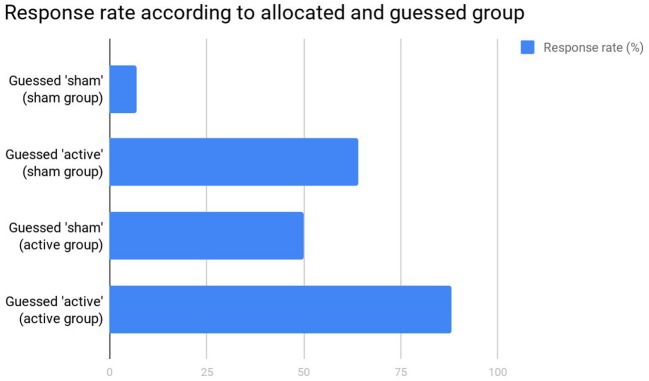
Response rates in the original study (Sampaio-Junior et al., 2018).